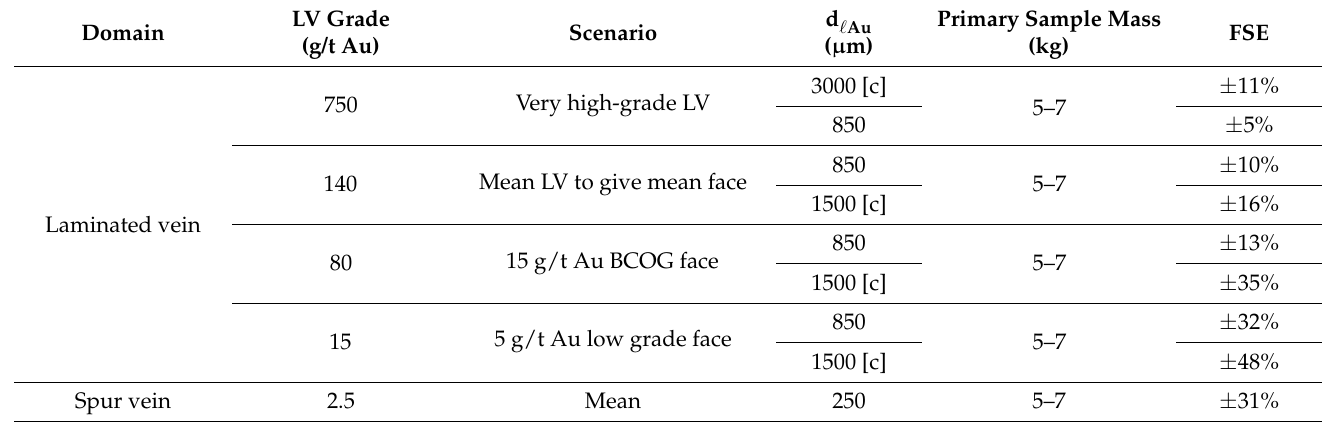
Table 19. FSE values for the original production sampling protocol by vein domain for different grade-liberation diameter scenarios. The primary sample mass is based on a 0.7 m wide laminated vein (LV) and 2.8 m of spur vein. [c]: